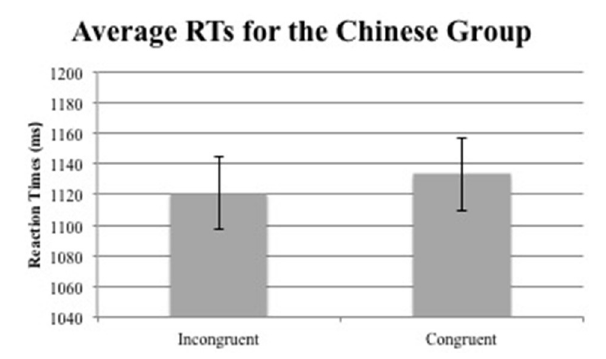
and the exact numbers of the means and standard error (SE) of each group in Table 2